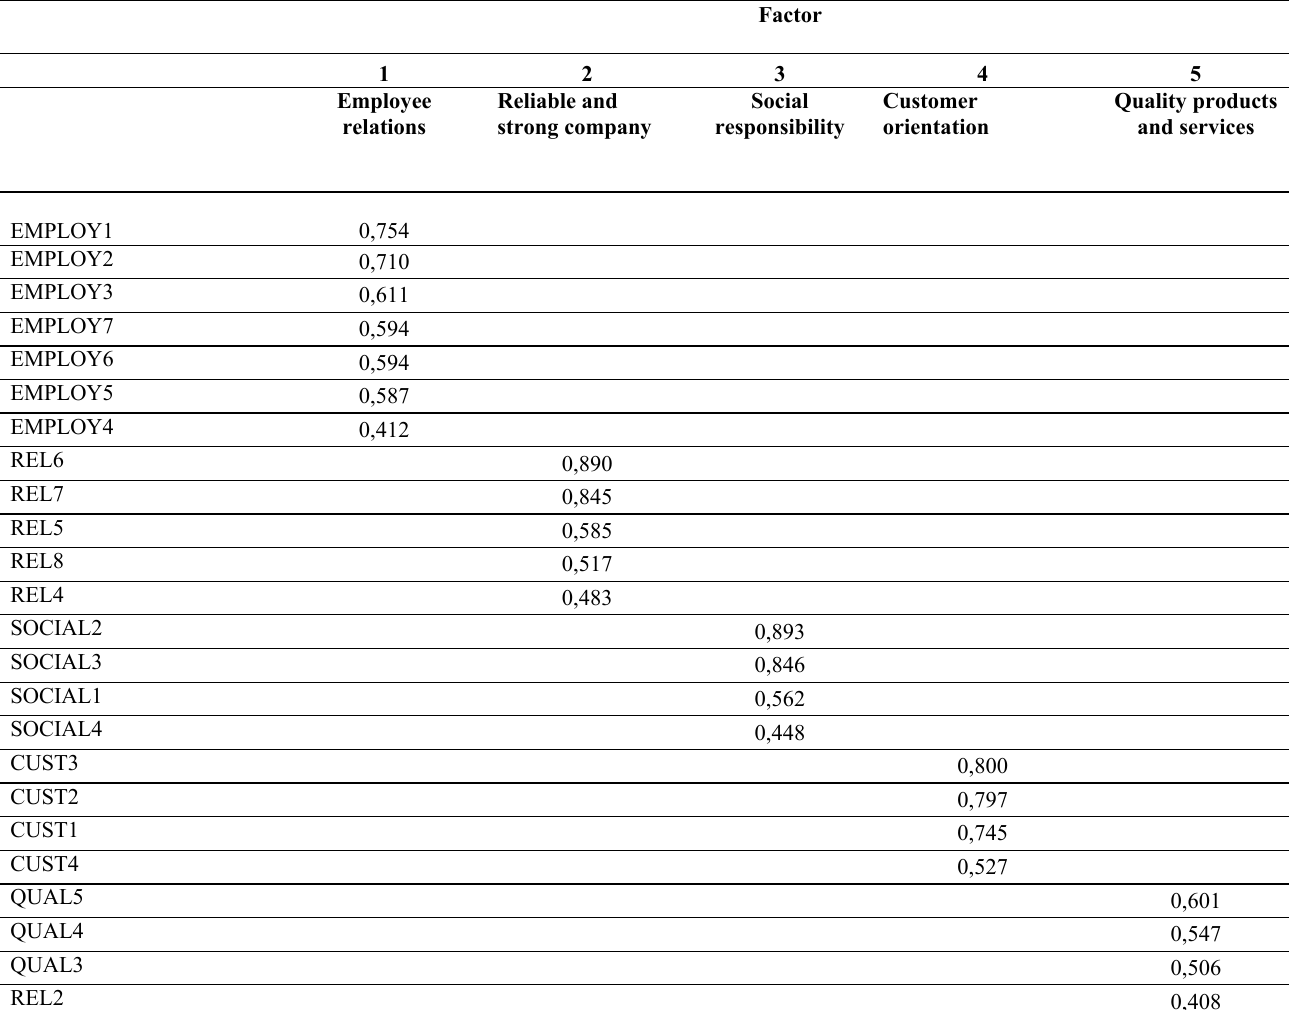
Table 1: Rotated factor loadings